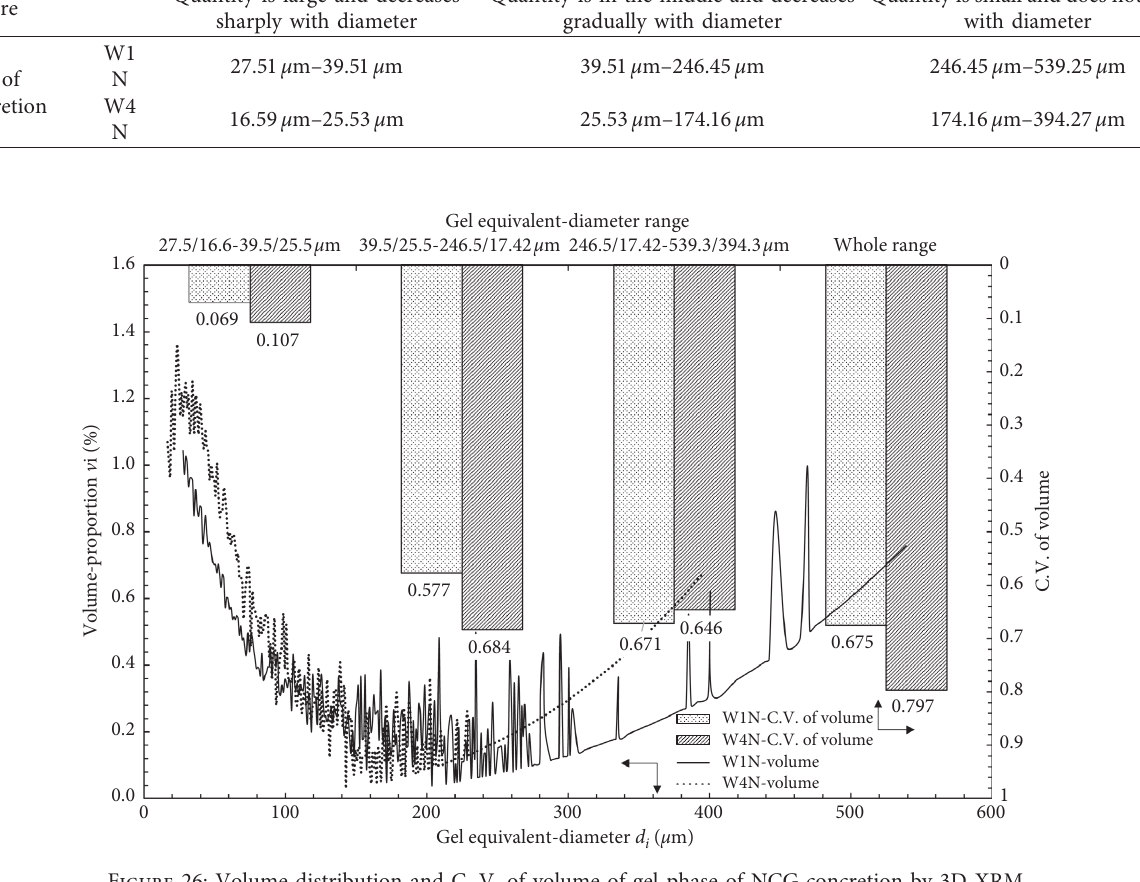
Figure 26: Volume distribution and C. V. of volume of gel-phase of NCG concretion by 3D-XRM.